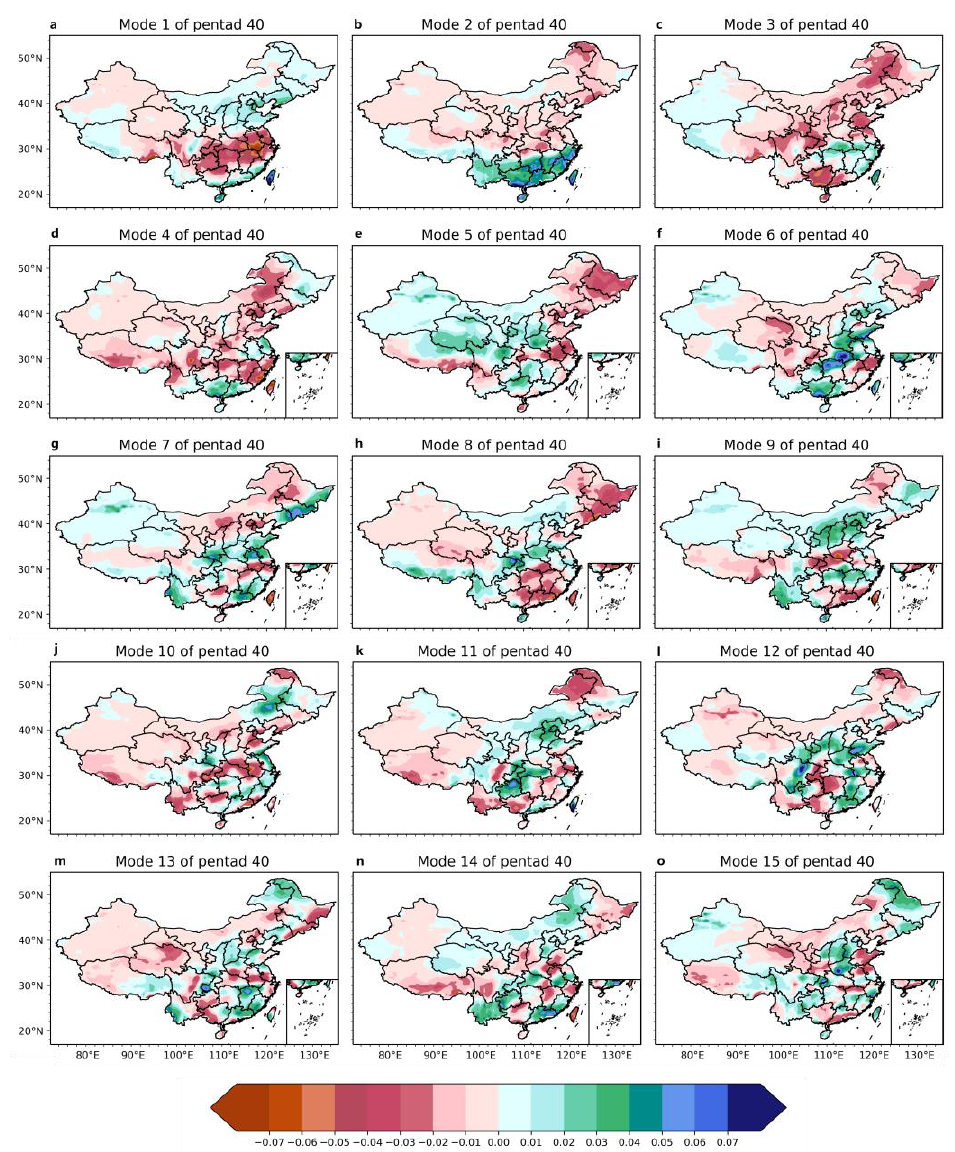
Figure 2. Left field of the 15 modes ( a – o , respectively) of the SVD decomposition (anomaly distribution of the pentad precipitation in the fourth pentad of July).